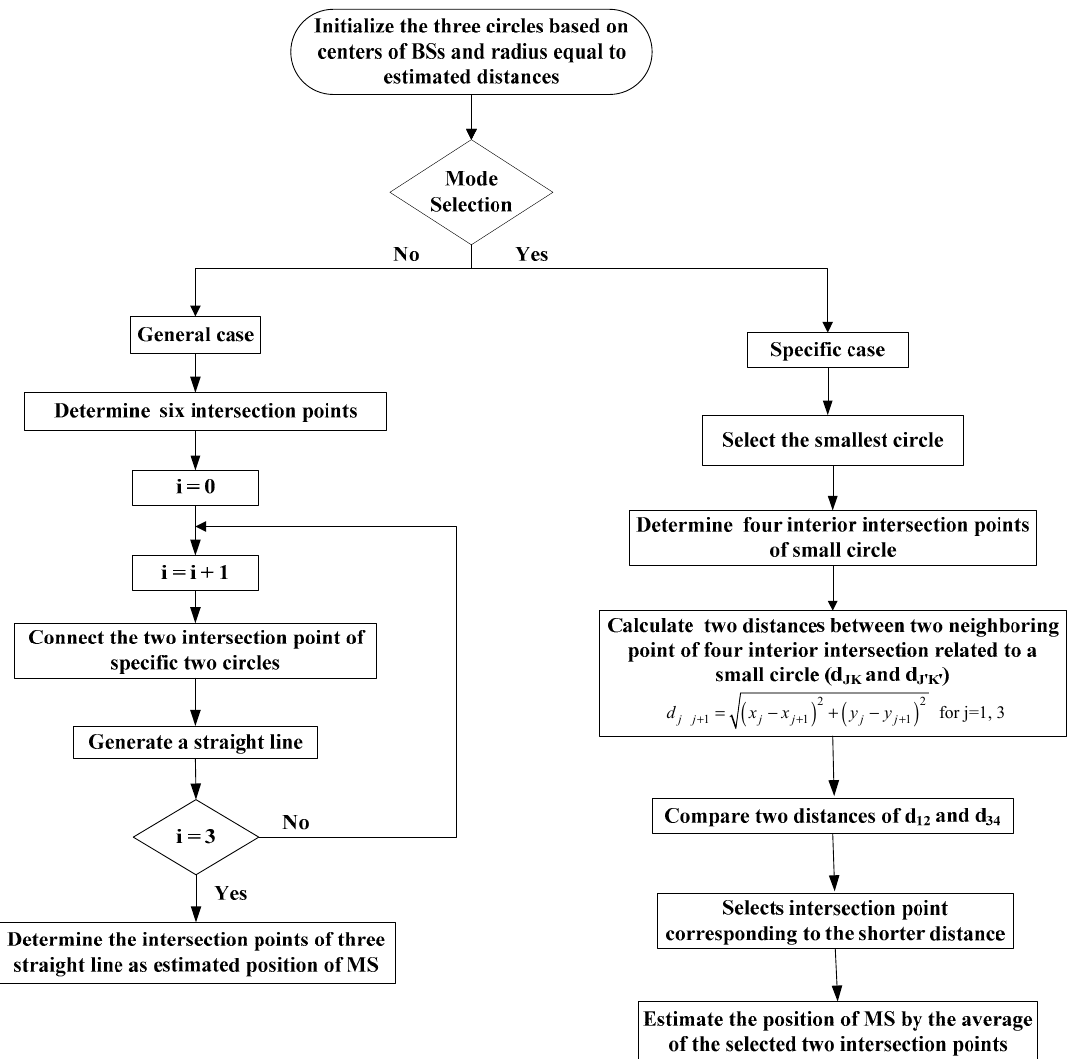
Figure 6. Flow chart of the proposed hybrid algorithm based on the line intersection algorithm and comparison approach of intersection distances.